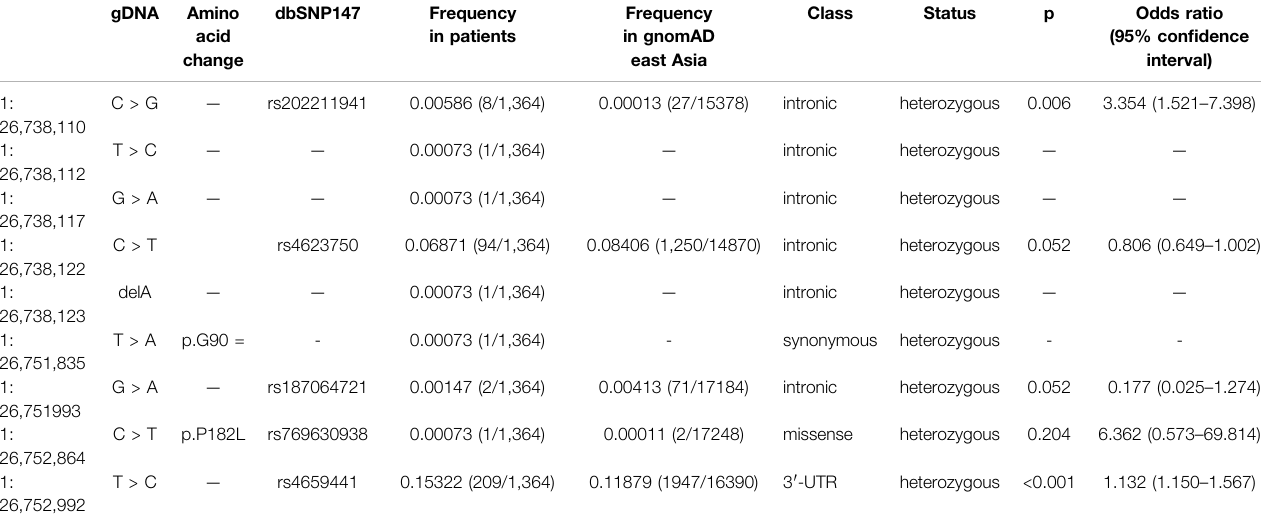
TABLE 1 | The description of variants in LIN28A identi fi ed in the EOPD patients. gDNA Amino acid